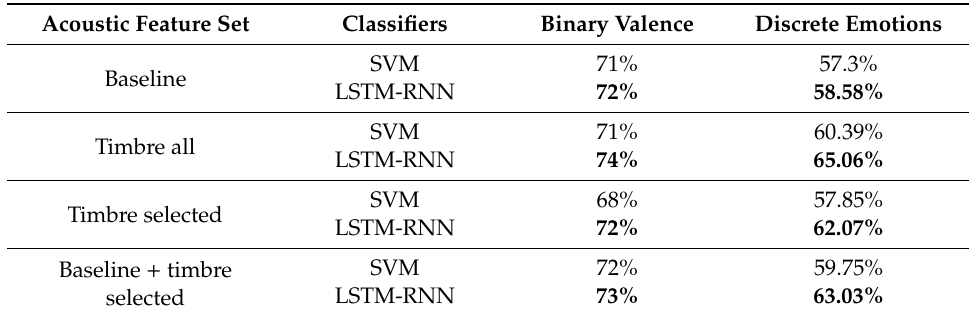
Table 5. Average accuracy rate in all experiments for IEMOCAP. (The bold indicates the highest accuracy